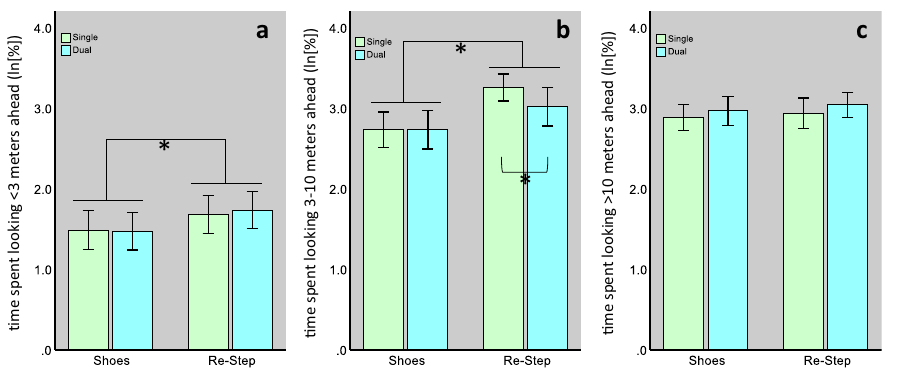
Figure 4. Percentage of time spent looking within the Short ( a ), Mid ( b ), and Long ( c ) distance categories by shoe type and task type. For both the Short and Mid distance categories, we found a significant main effect for the shoe type. For the Mid distance category, we also found a significant difference between single- and dual- task walks made with the RS. [*] indicates a significant difference. Bars represent mean values and error bars the 95% CI of the